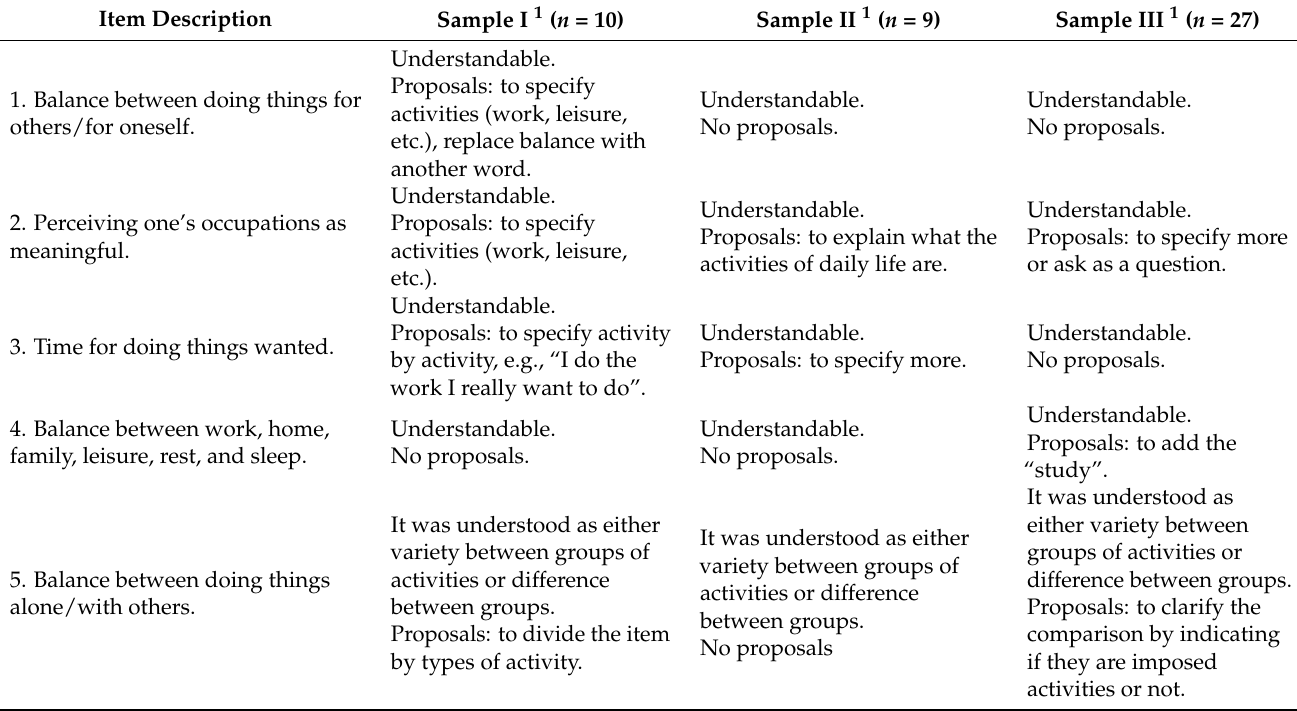
Table 2. Analysis of the participant comments and proposals on the final Spanish version of OBQ tested in the pilot study ( n =